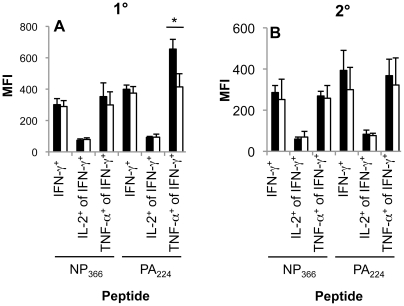
Impaired polyfunctionality of DbPA224-specific CD8+ T cells in the aged mice during primary but not secondary influenza infection.(A) Primary or (B) secondary (primed young) influenza-specific CD8+ T cell responses were assessed for simultaneous production of IFN-γ, TNF-α and IL-2 in the spleen of aged (22 months old) and young (6–8 weeks) mice. Compiled data (n = 3–5, mean±SD) are shown for the mean fluorescence intensity (MFI) of IFN-γ, IFN-γ and TNF-α as well as IFN-γ and IL-2 staining. * = p<0.05. Experimental outline as in Figure 1AB.